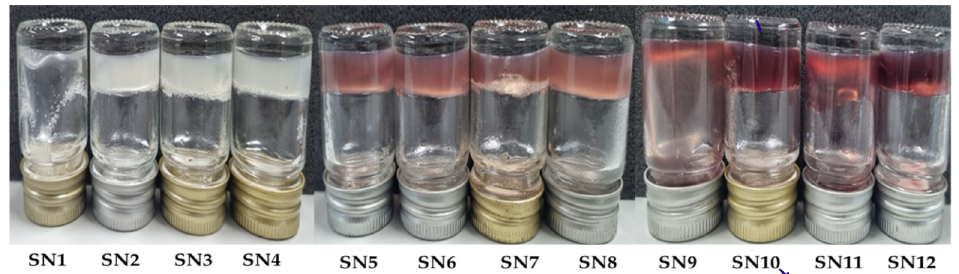
Figure 1. Characteristics of sericin-hydrogel formulations (SN1–SN12). Table 2. Physical characteristics and total anthocyanin content of sericin hydrogels and